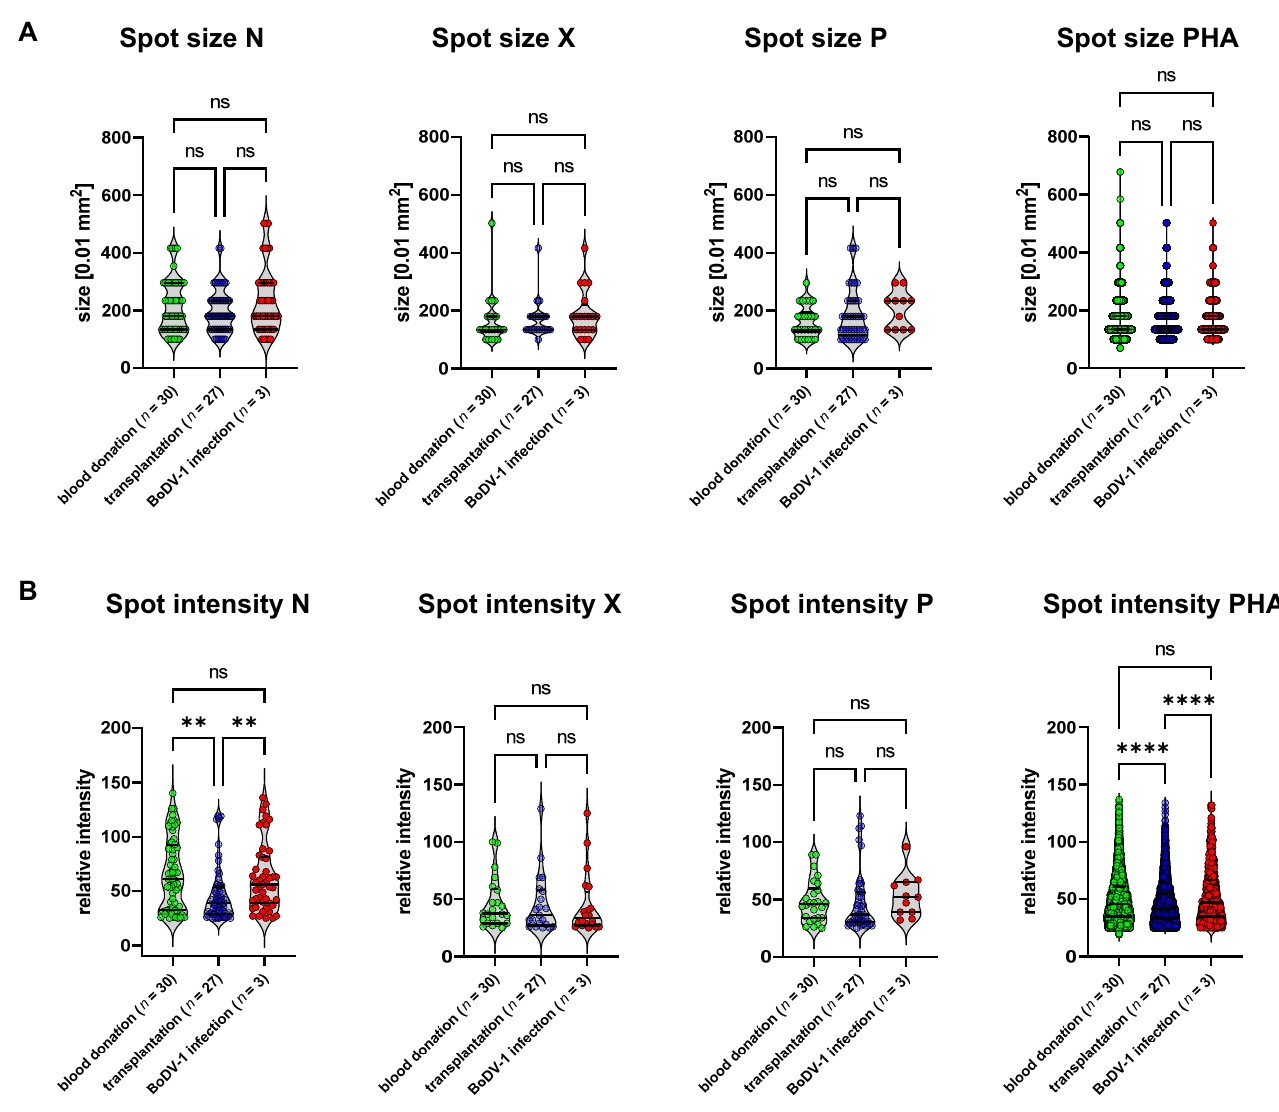
Figure 2. Spot sizes and spot intensities of BoDV-1 ELISpot. Distributions of spot sizes [0.01 mm 2 ] ( A ) and spot intensities ( B ) are depicted as violine plots (horizontal lines: median and quartiles) for different conditions (stimulation with BoDV-1-protein-derived peptides or PHA) and cohorts. For statistical analysis, a Kruskal-Wallis test followed by Dunn’s multiple comparisons test was performed (ns p > 0.05; ** p ≤ 0.01; **** p ≤ 0.0001).